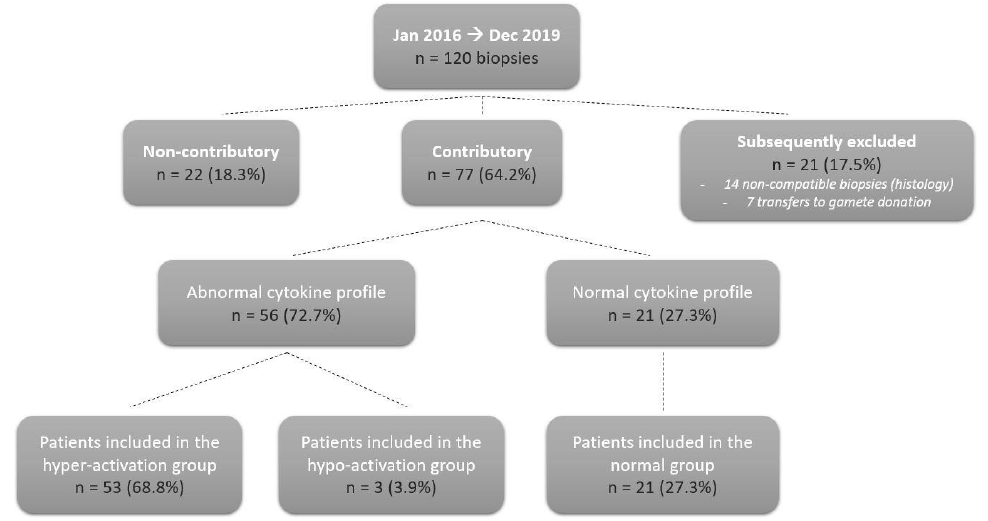
Figure 2. Study flow diagram. Table 1. The characteristics of the study participants, according to their endometrial profile.